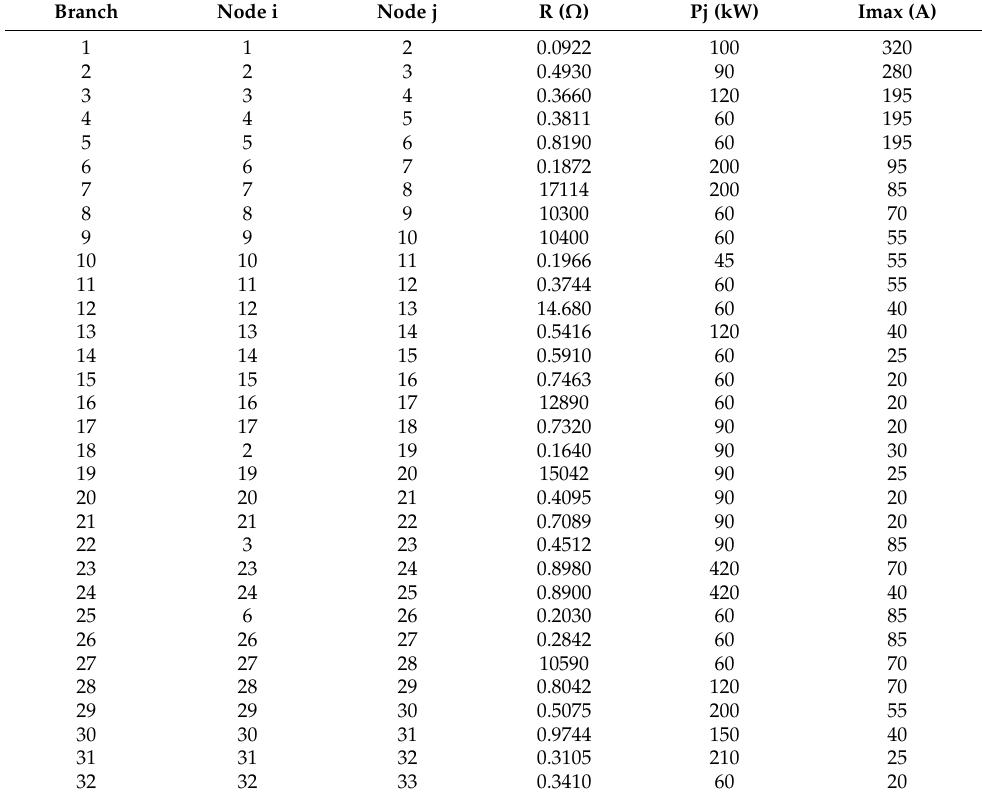
Table 2. Parametric information for branches and loads in the IEEE 33-node grid.